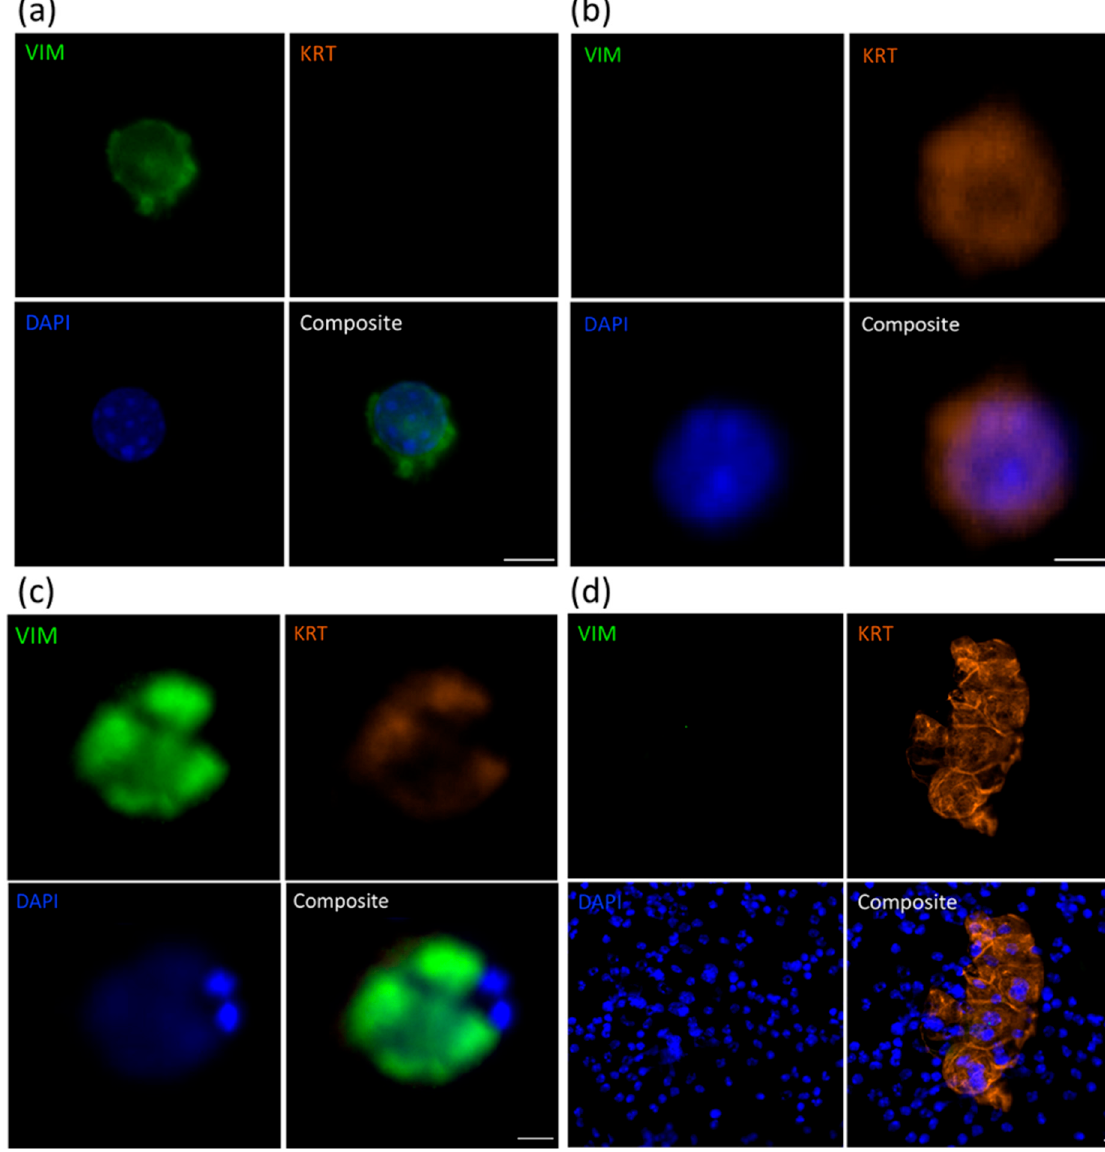
Figure 1. Immunofluorescence staining for vimentin (VIM) and cytokeratins 8/18/19 (KRT) in PDX-derived CTCs. Repre- sentative images of LuCaP70 CTCs staining for ( a ) VIM only, ( b ) KRT only or ( c ) both VIM and KRT; ( d ) KRT-positive CTC cluster surrounded by murine PBMCs. Scale bar denotes 5 µm.